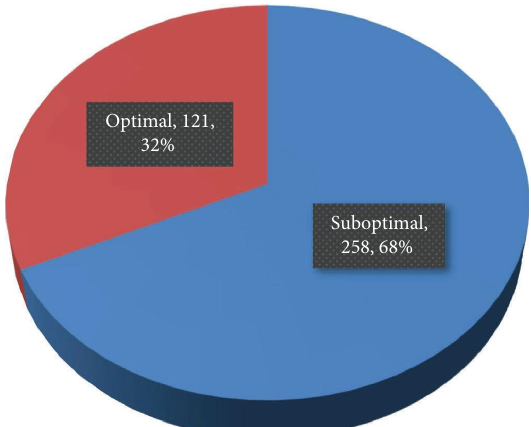
Figure 4: Contrast enhancement adequacy for patients with postcontrast abdominal CTat TASH with optimal defned as > 50HU increase from precontrast to portal venous phase, 2022 G.C.